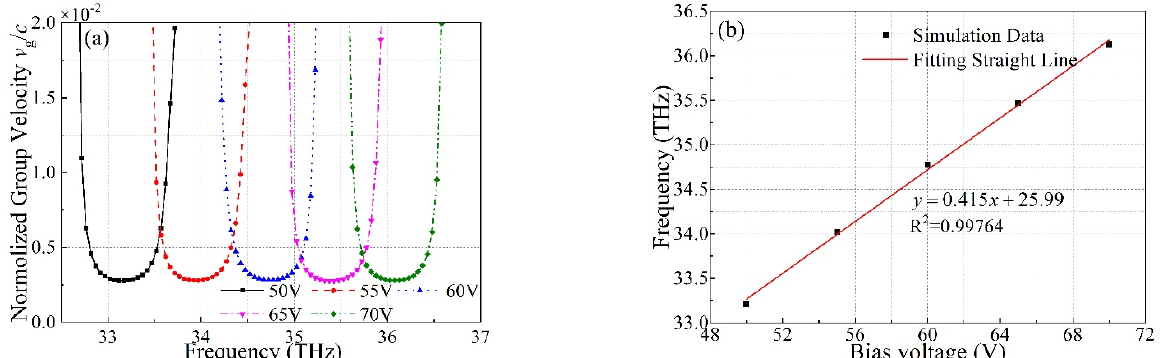
Figure 6. ( a ) The normalized group velocity v g /c and ( b ) center frequencies of the working channel of the graphene waveguide with different bias voltages.